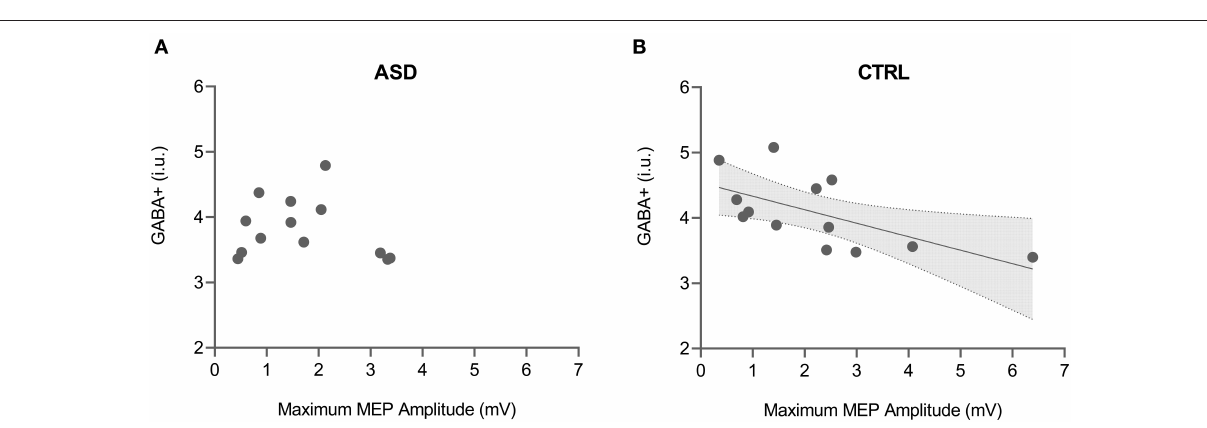
FIGURE 4 | Correlation between GABA + levels and maximum MEP amplitude from input-output TMS protocol for both ASD (A) and control (B) groups. Shaded area in the scatter plot represents 95% CI for the significant correlation. ASD, Autism Spectrum Disorder group; CTRL, control group; GABA + , gamma-aminobutyric acid; MEP, motor-evoked